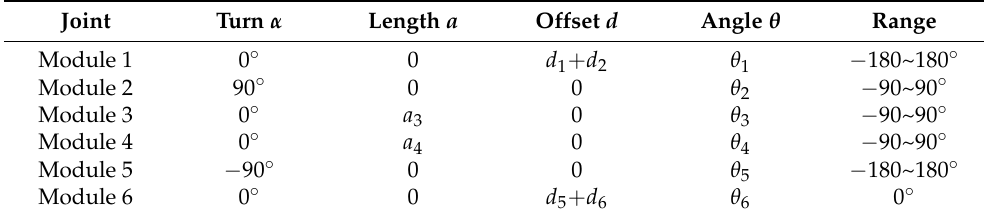
Table 2. Modular robotic D-H parameter table 162